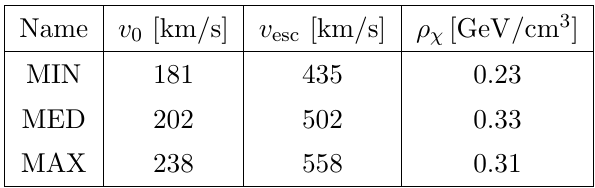
Table 1 . The best-(cid:12)t values of the Maxwellian distribution of the local DM speed distribution and the corresponding escape velocity as well as average dark matter density in the torus region of the TNG100 MW-like